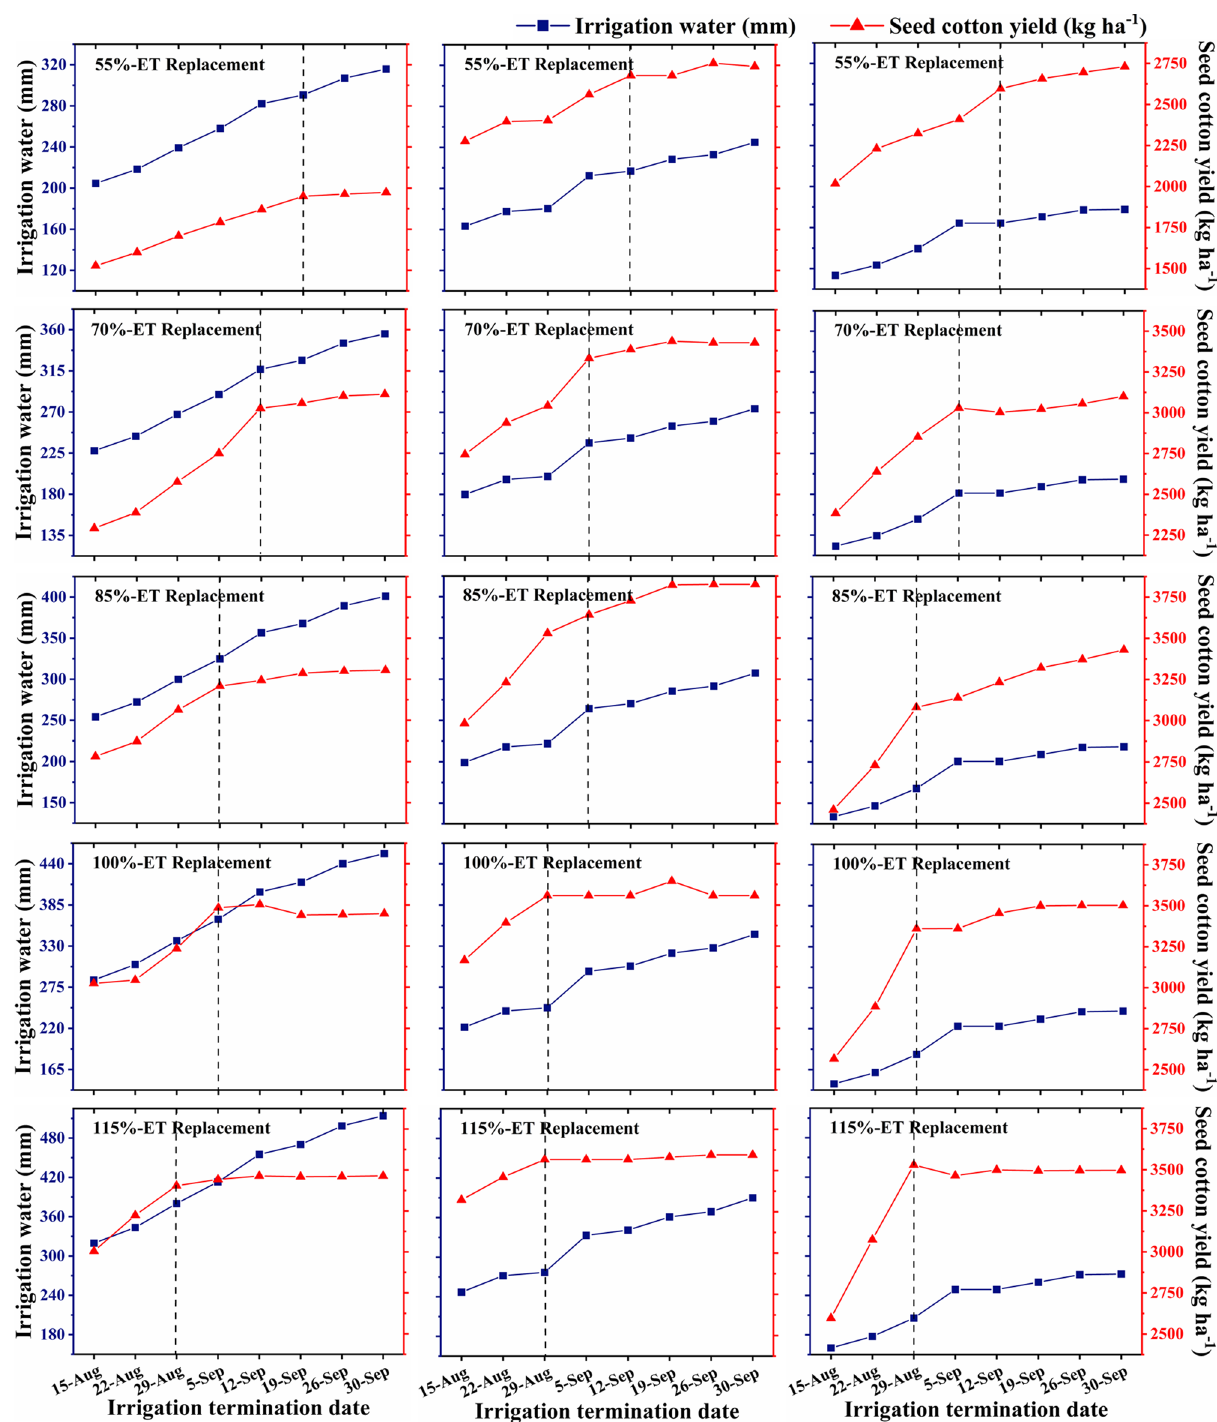
Figure 3. Effect of irrigation termination date on median irrigation water use and seed cotton yield under different excess/deficit irrigation strategies. The vertical dotted line indicates the irrigation termination date after which an increase in average seed cotton yield from that termination date to the next termination date was < 3%. (Left, center and right panels correspond to dry, normal, and wet years,